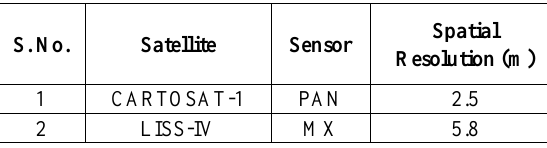
Table1: Details of Satellite